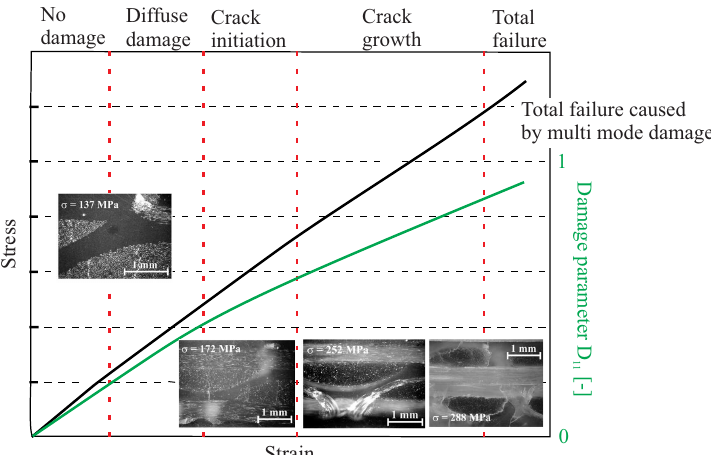
Figure 2. Schematic example of the gradual damage behaviour of a [ 0 ◦ /90 ◦ //90 ◦ /0 ◦ ] glass fibre- reinforced epoxy under homogeneous tensile loading [19].